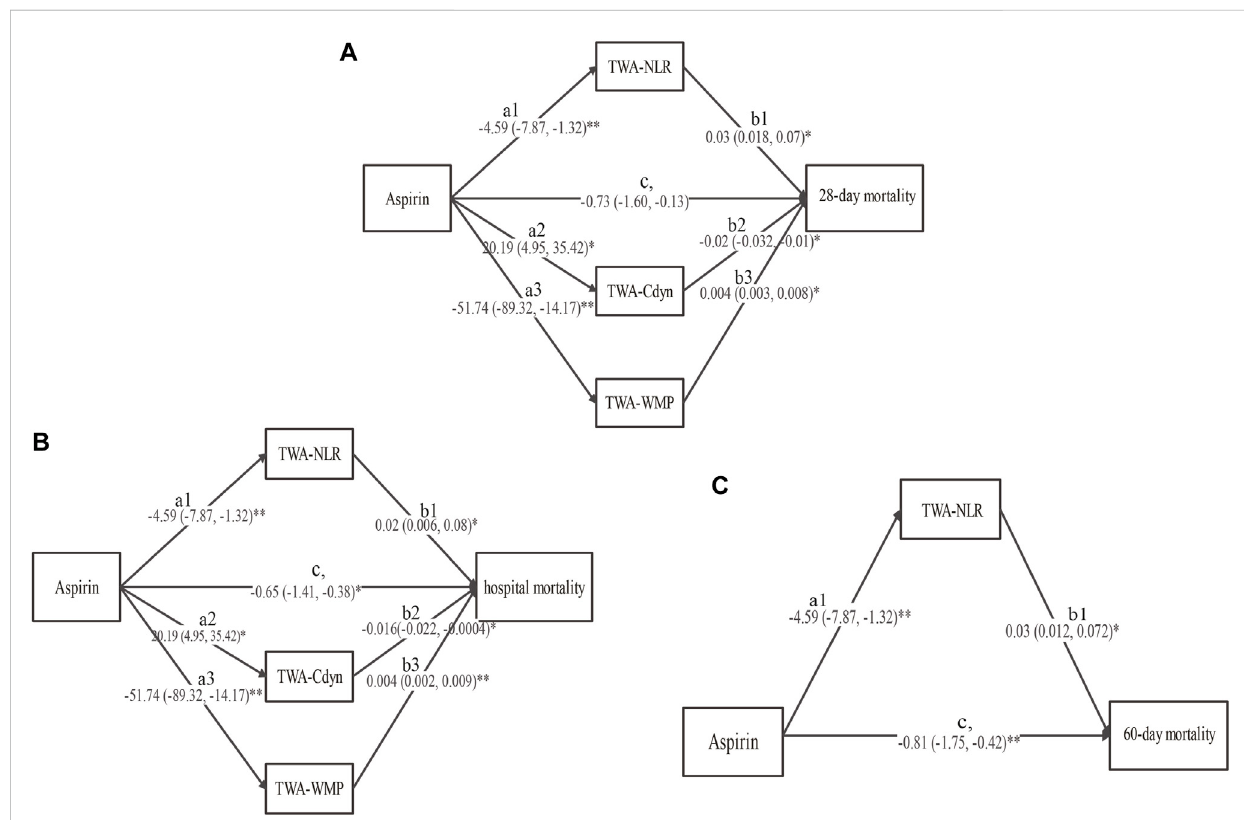
FIGURE 3 The results of the multiple mediation analysis between low-dose aspirin exposure before ICU admission and (A) 28-day mortality, (B) hospital mortality, and (C) 60-day mortality. Solid line indicates a signi fi cant effect in the path, * p < 0.05, ** p < 0.01. TWA-RDW: time-weighted average red